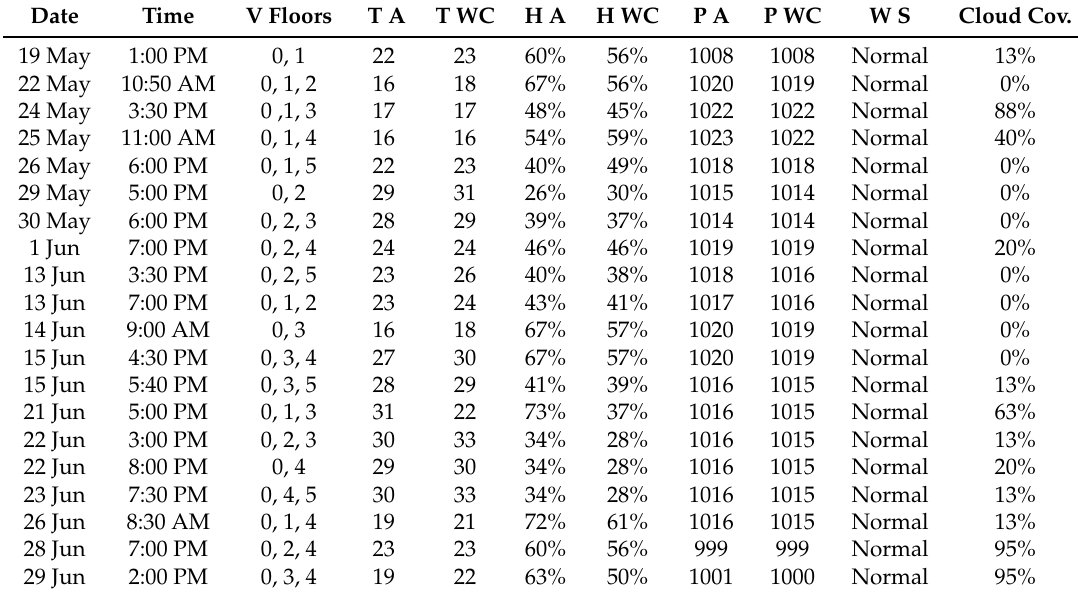
Table A3. Collected data used for evaluation of Deutsch Akademie building. The table shows the data acquisition date, the time, the visited floors (V Floors), the indicated temperature from AccuWeather (T A) and the Weather Channel (T WC), the humidity from the same two sources (H A) and (H WC), the ambient pressure from AccuWeather (P A) and from the Weather Channel (P WC), the walking speed (W S) and the cloud